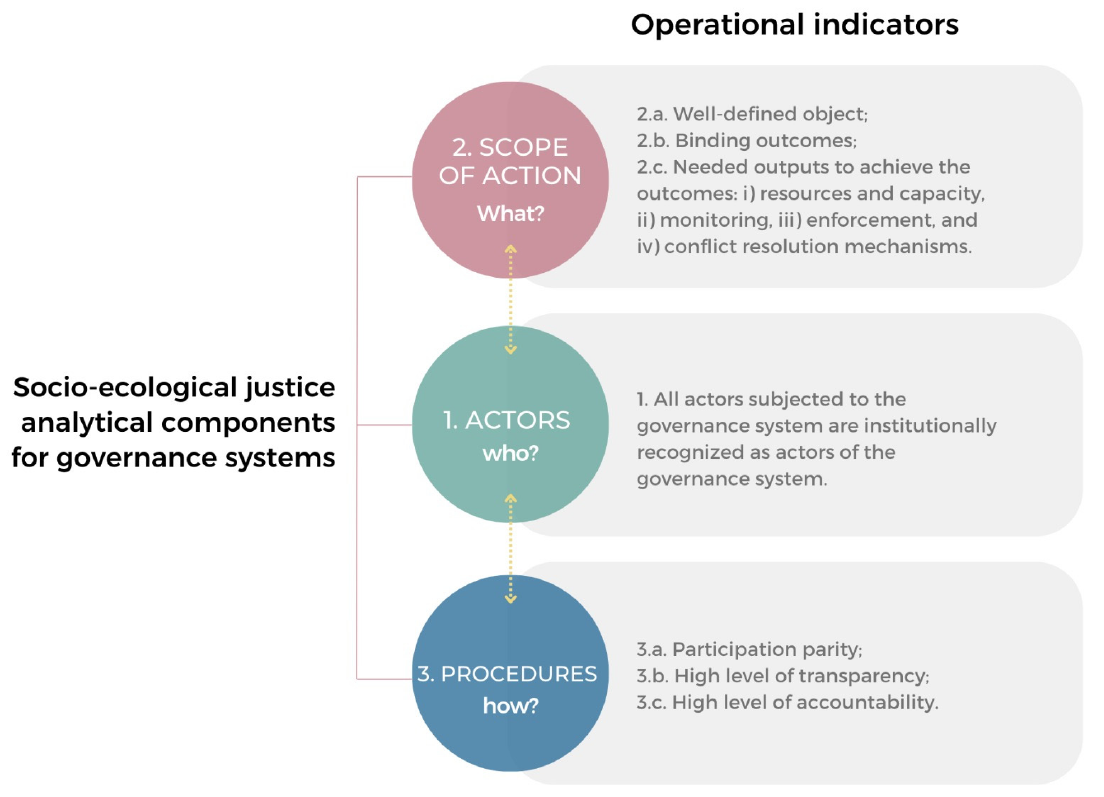
Figure 2. The three analytical components of the governance of socio-ecological systems and its operational indicators that guided the research.